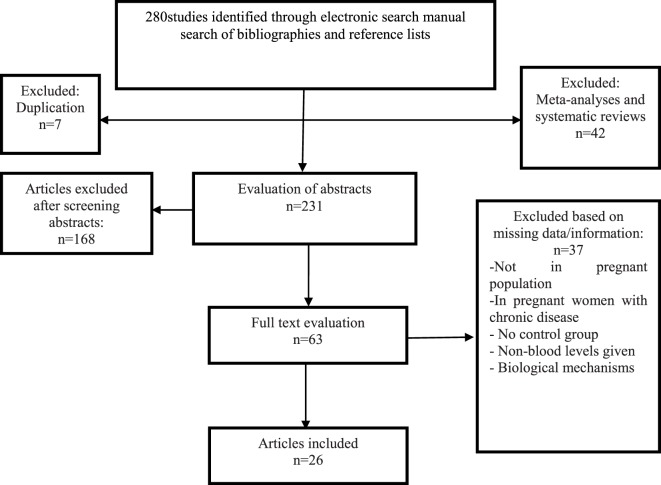
Flowchart of the literature search.